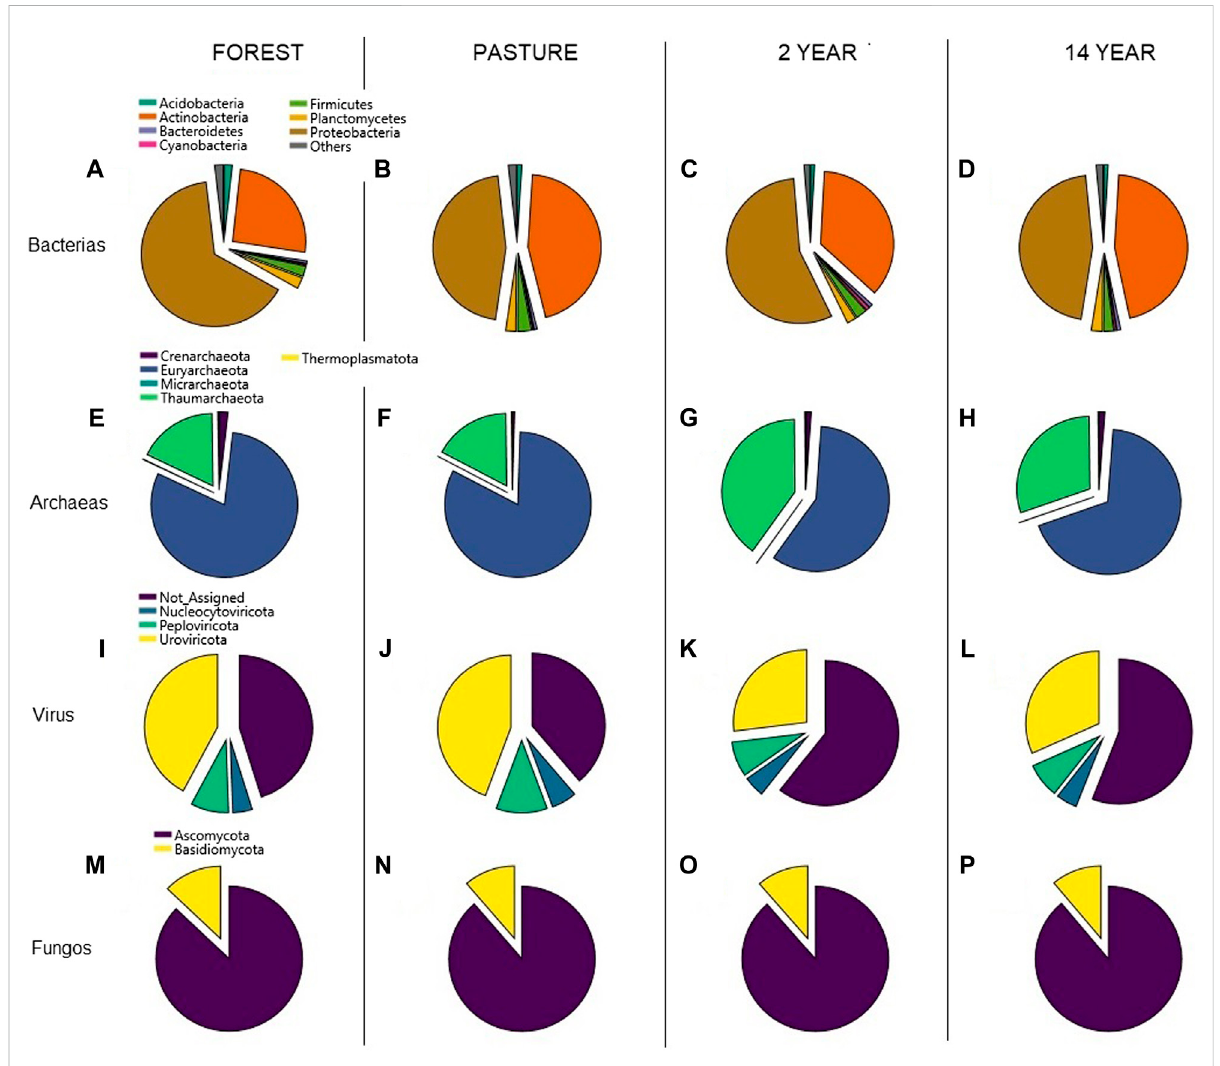
FIGURE 1 Abundanceofthedifferentphyla ofthemicroorganisms identi fi edintheforest sitescorrespondsto (A,E,I,M) ;pasturecorrespondsto (B,F,J,N) ; 2 years corresponds to (C,G,K,O) ; 14 years corresponds to (D,H,L,P)